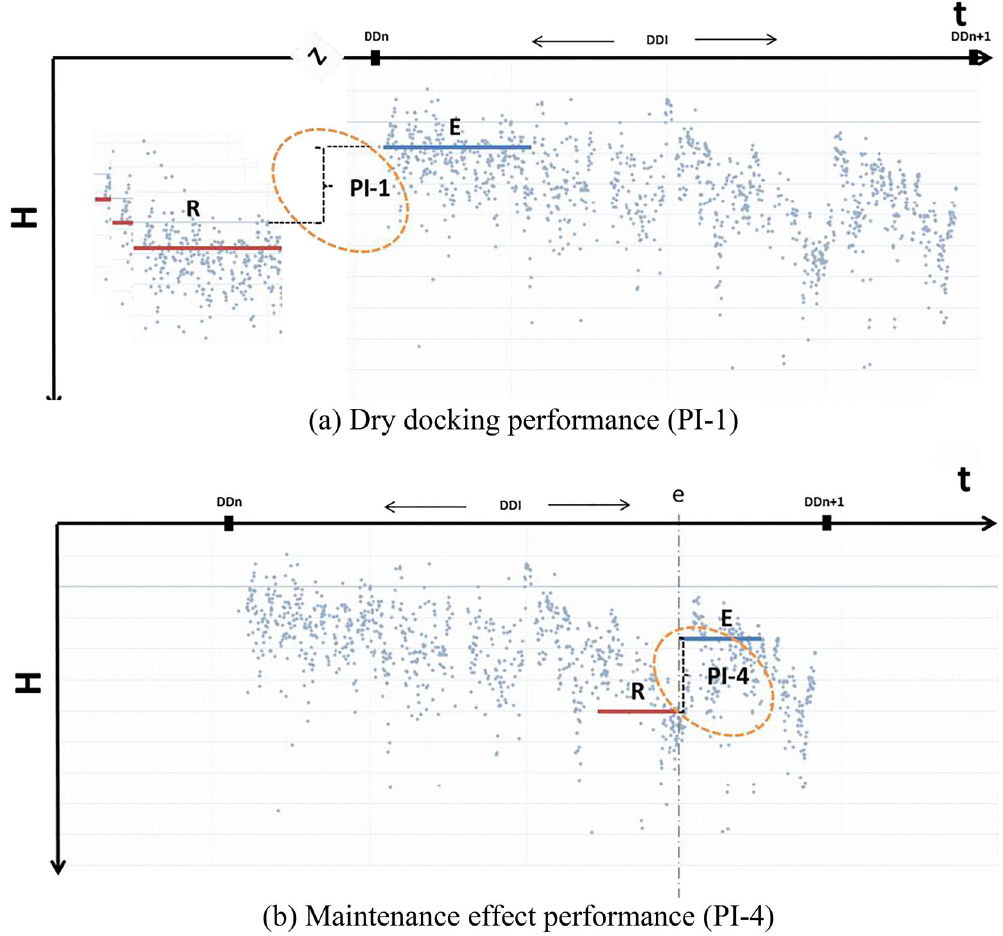
Figure 5. Definitions of performance indicators (PIs) considered in this study (taken from ISO 19030-1 12 ).